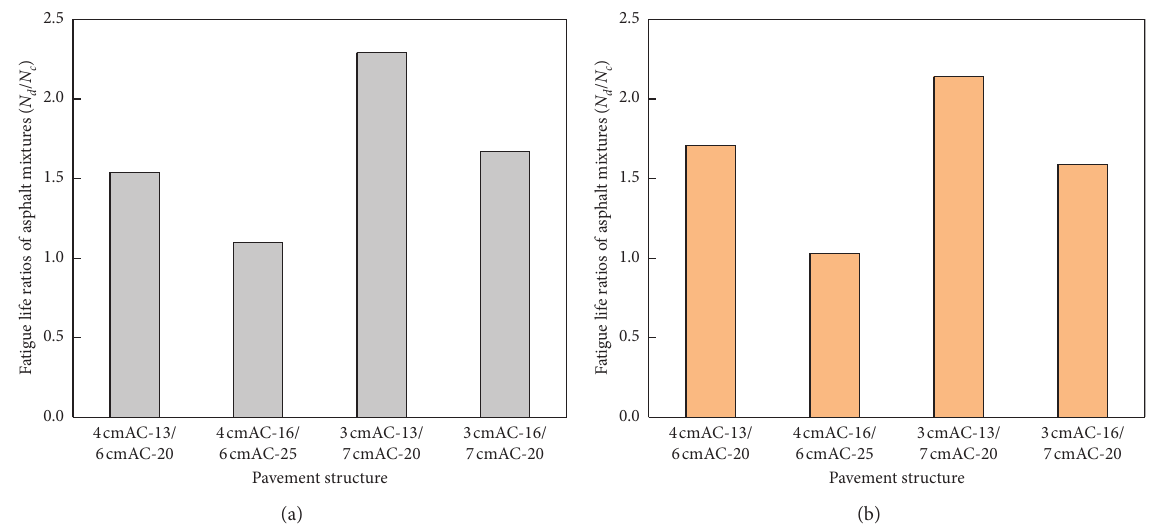
Figure 8: Ratio of fatigue life of specimens with the double-layer paving technology to the 4-cm AC-13 surface layer/6-cm AC-20 bottom layer with traditional paving technology. (a) Failure probability � 5%. (b) Failure probability � 50%.